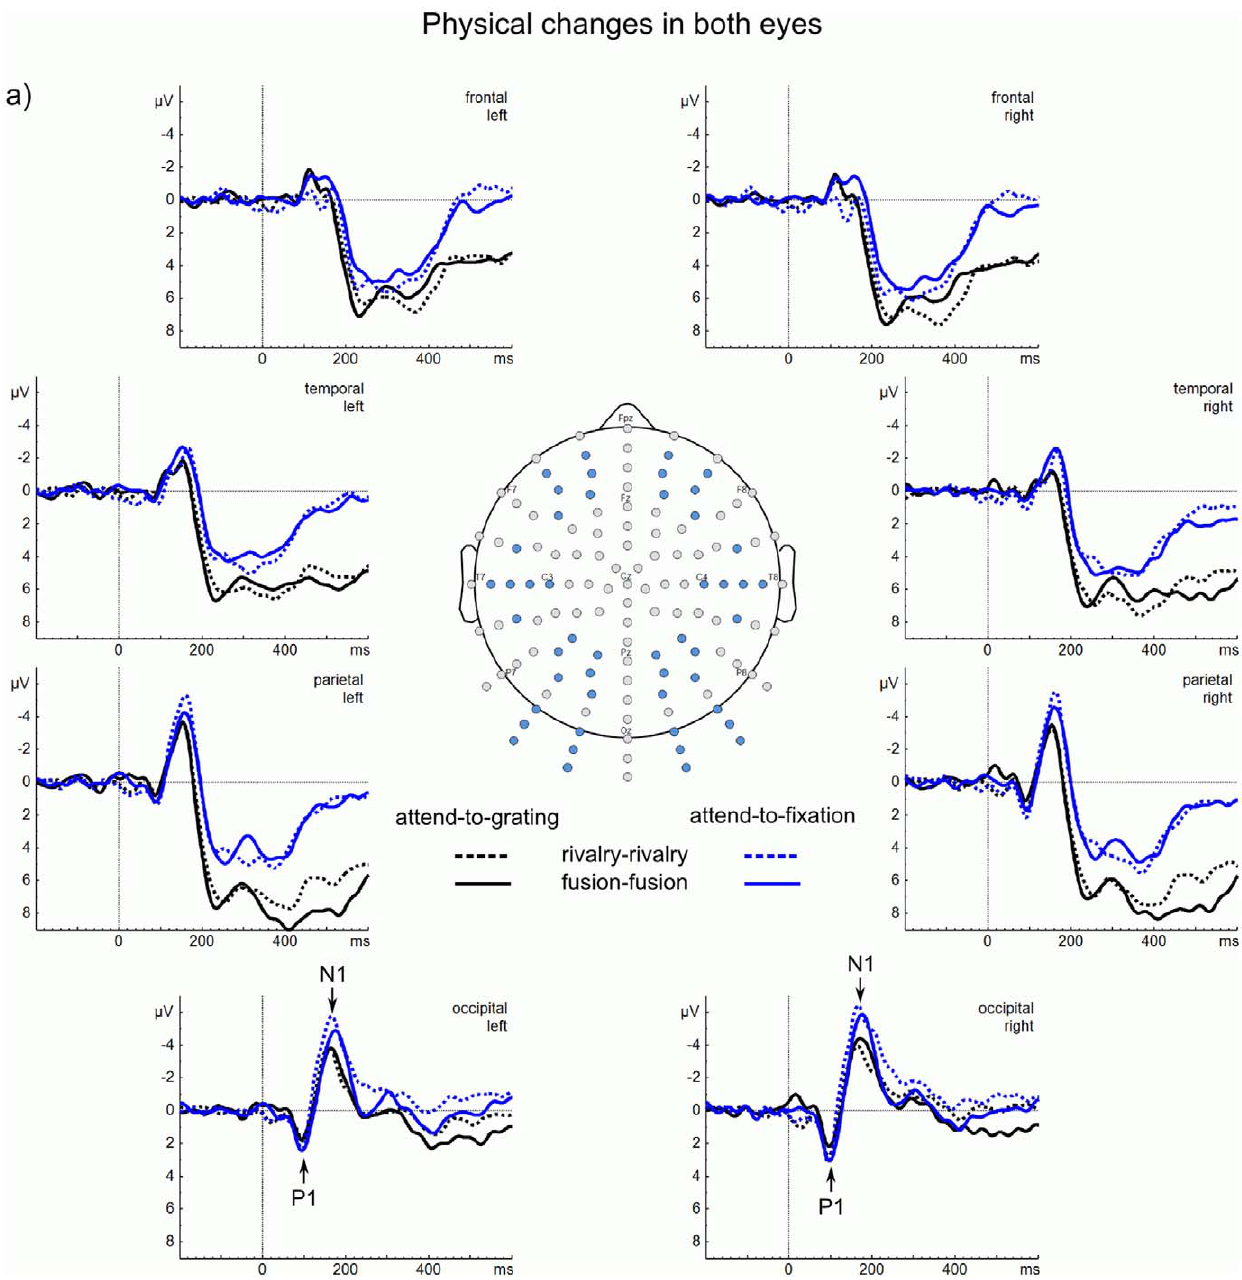
Figure 3. ERPs to changes in both eyes. (a) ERPs averaged within clusters of six electrodes at frontal, temporal, parietal, and occipital regions for the left and right hemispheres involving orientation changes in one eye (rivalry–rivalry—dotted lines and fusion–fusion—solid lines) from the attend- to-grating condition (black lines) and from the attend-to-fixation condition (blue lines). The major ERP components are marked with letters (P1, N1). Again, the N1 is greater in the attend-to-fixation conditions than in the attend-to-grating conditions; this is most pronounced from the occipital sites.